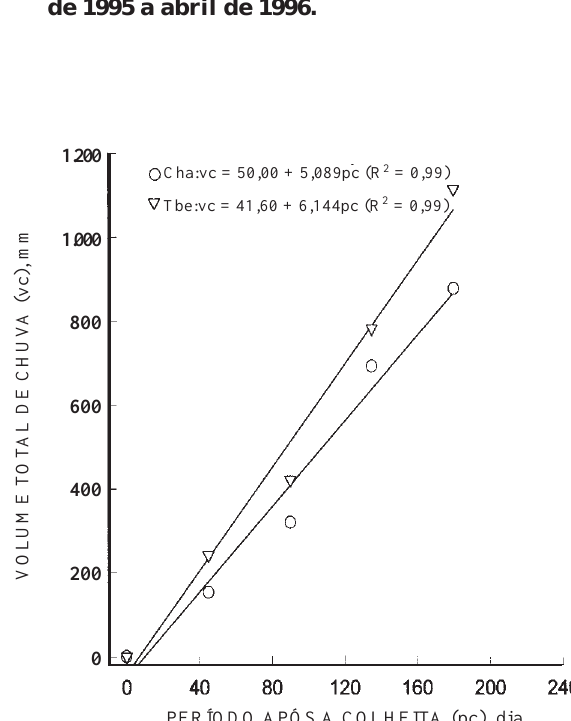
Figura 2. Volume total de chuva (vc), precipitado em Lages (Cha), e Lebon Régis (Tbe), no período de 180 dias após a dessecação/rolagem da cultura de aveia (pc), de outubro de 1995 a abril de 1996.